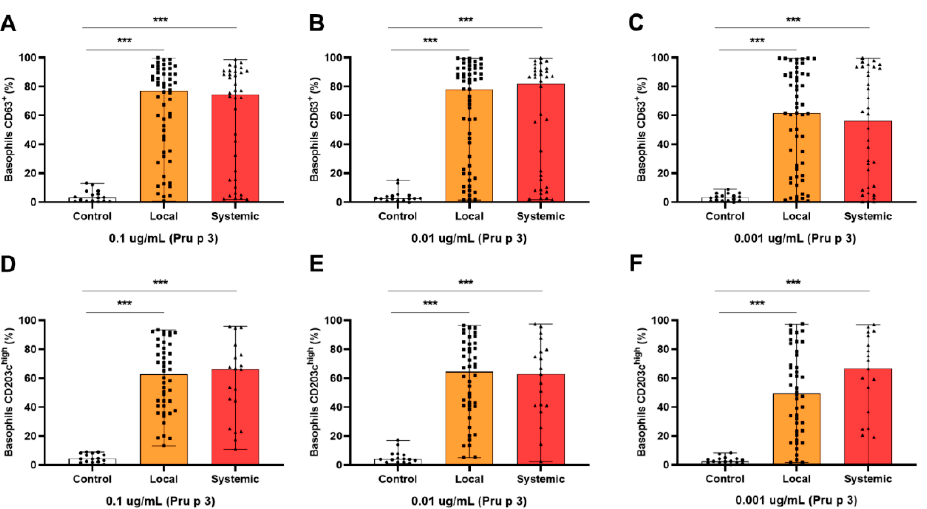
Figure 3. BAT does not distinguish LTP-allergic patients according to severity of symptoms. BAT parameters %CD63 + ( A – C ) and %CD203c high ( D – F ) were compared between healthy controls, the whole LTP-allergic population, and the different clinical severity groups at the three selected con- centrations of Pru p 3. In all cases, significantly higher activations of basophils, measured in terms of %CD63 + and %CD203c high , were found between all LTP-allergic patients and controls, and the different clinical groups (OAS, URT/ANG, and ANAPH) and healthy individuals. Levels of %CD63 + and %CD203c high were similar among patients with OAS, URT/ANG, and ANAPH in all concentra- tions of Pru p 3 used. *** p < 0.001, **** p < 0.0001. ANAPH, anaphylaxis; OAS, oral allergy syndrome; URT/ANG, urticaria/angioedema.